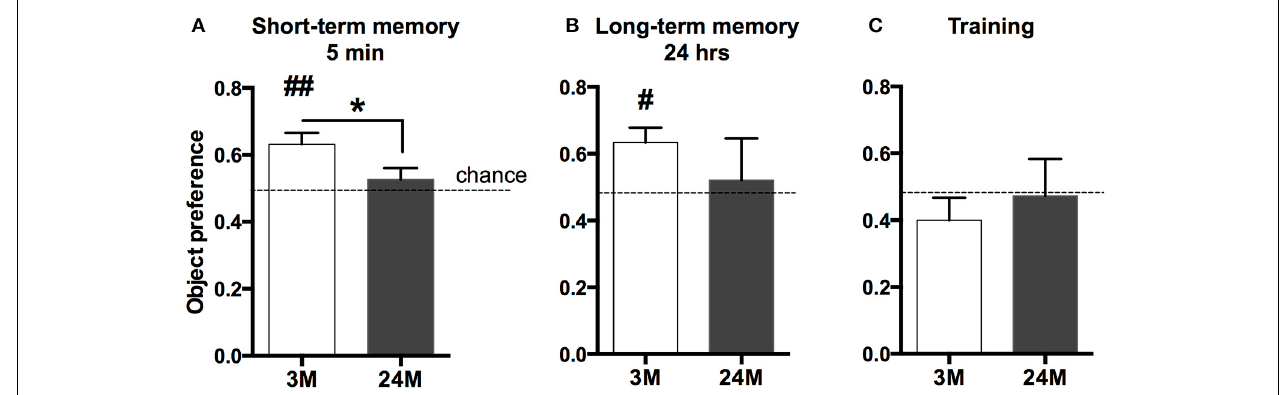
t -test; ## p < 0 . 01 vs. chance level, one-sample t -test; n = 11 [ 3M]/9[24M]). (B) To test long-term memory mice were exposed to the arena 24h later, now containing another novel object (A + C). While object preference in 3M was significantly higher than chance level ( # p < 0 . 05, one-sample t -test, n = 10), 24M animals ( n = 4) performed at chance level, indicating impaired long-term object recognition memory in aged mice. Error bars indicate s.e.m. (C) During the training session, none of the groups showed preference for any of the two equal objects (A +